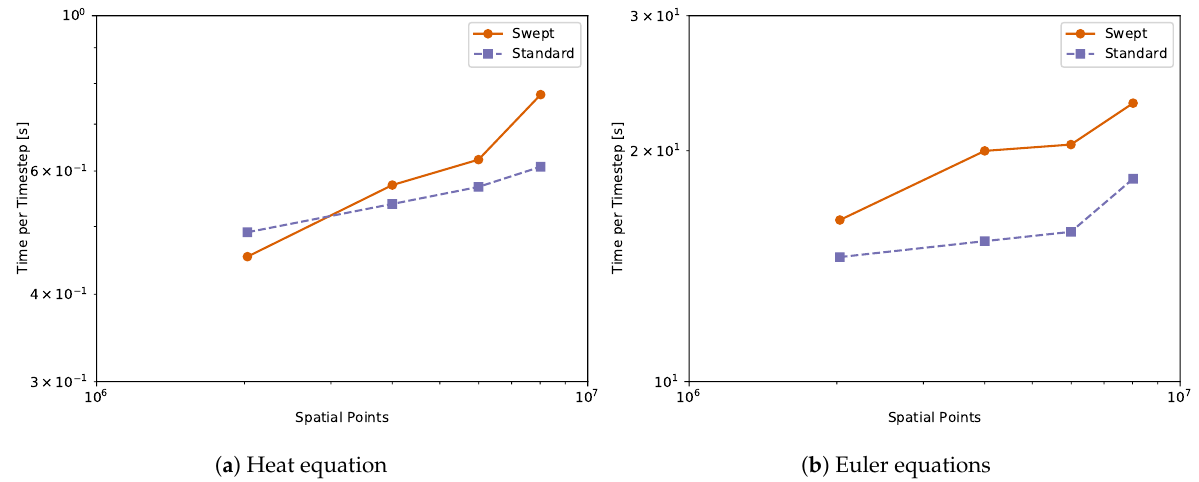
Figure 11. Weak scalability time per timestep results with a share of 90%, blocksize of 16, and 500